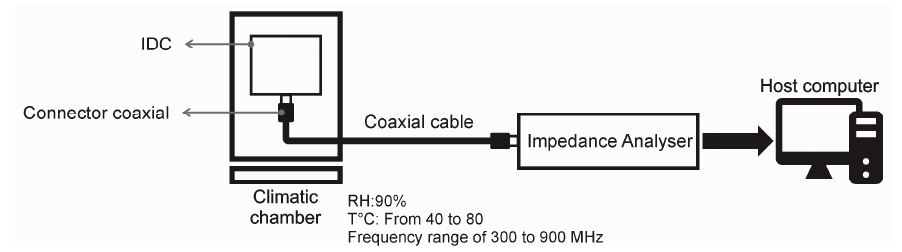
Figure 1. Experimental setup used for the electrical capacitance tests. IDC: interdigital capacitors.